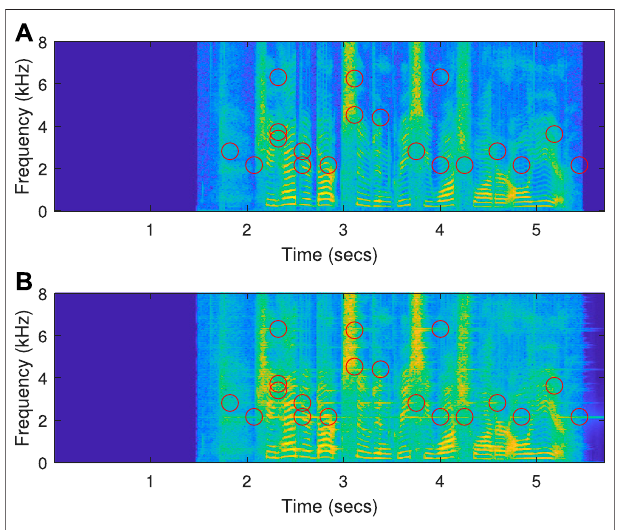
FIGURE 6 | Spectrogram comparison for K = 6 (above MSG): (A) Spectrogram of u 1 ; (B) spectrogram of y . The howling artifacts in y were retrospectively detected via mic1 using the howling detector, and (some of them) are marked in both (A,B) by red circles.